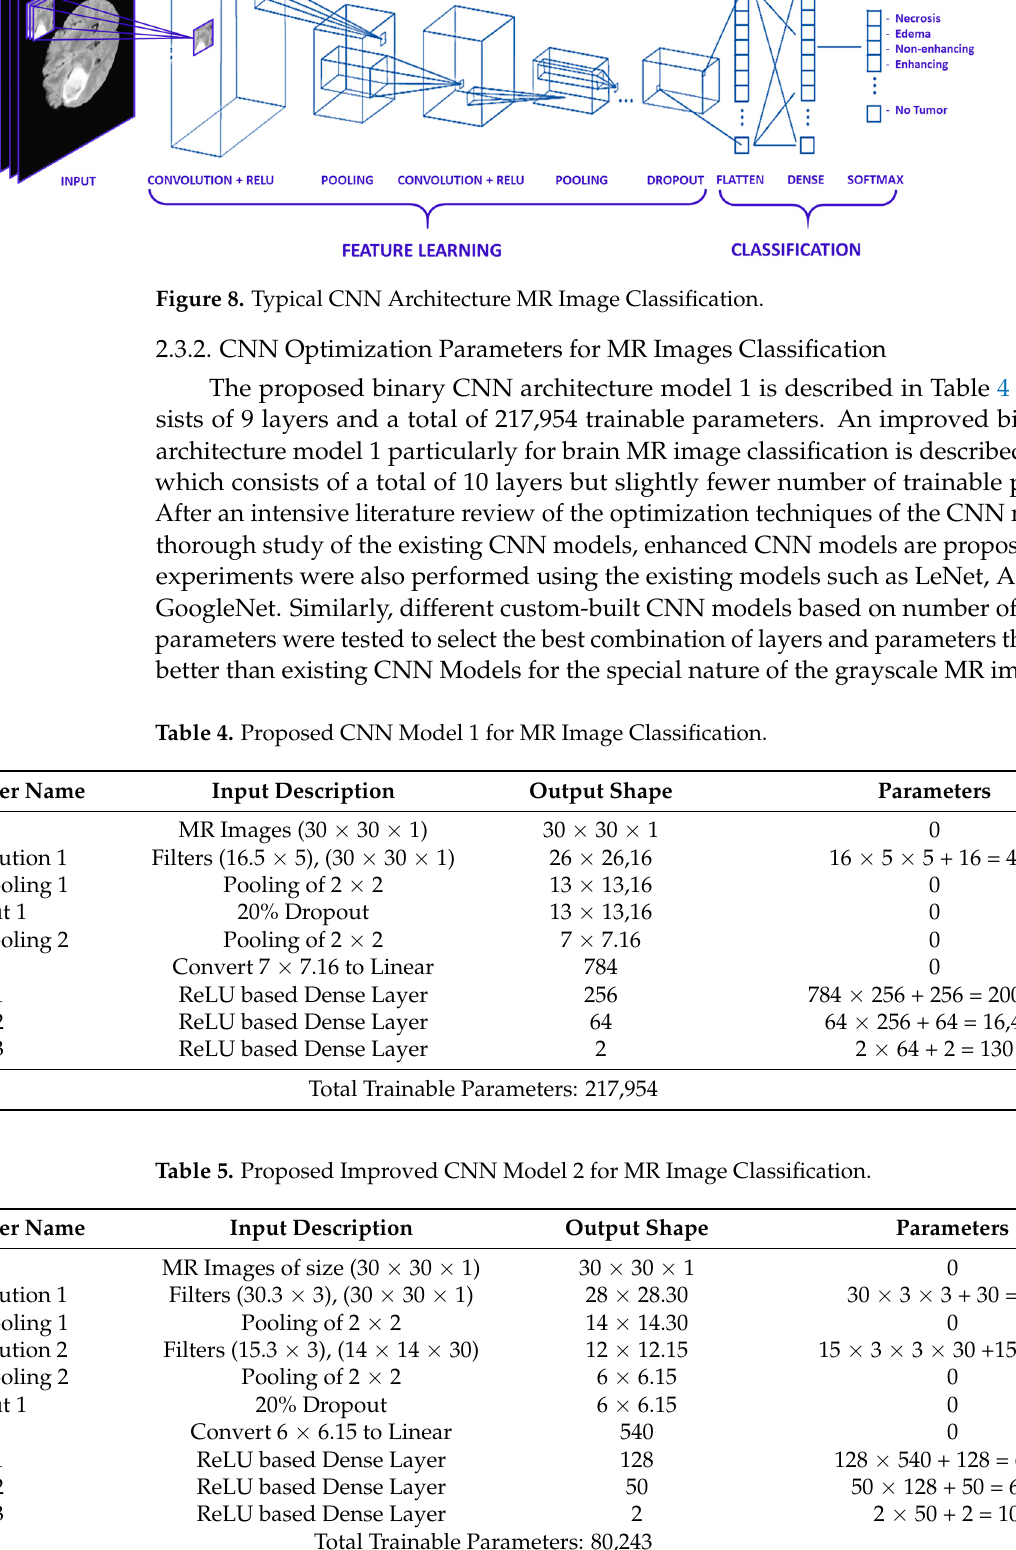
Table 5. Proposed Improved CNN Model 2 for MR Image Classification.